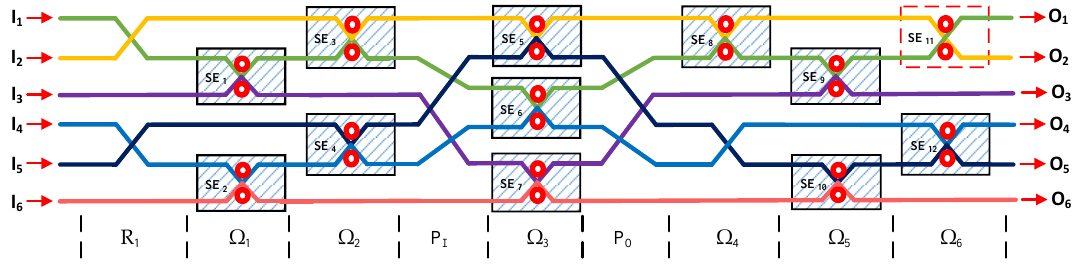
Figure 5. Routing example of I/O link SC 6 for straight mapping .